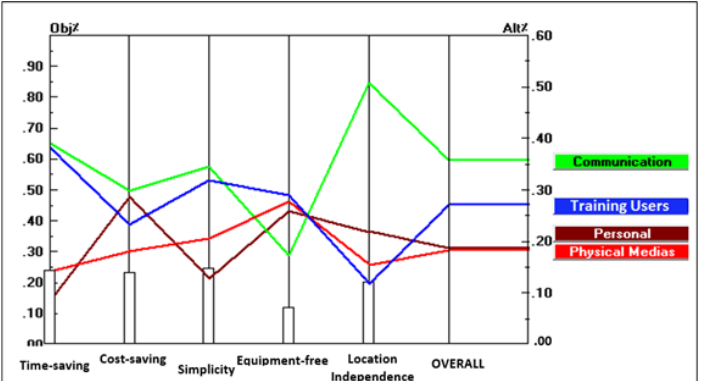
Figure 2 Performance sensitivity graph of alternatives and